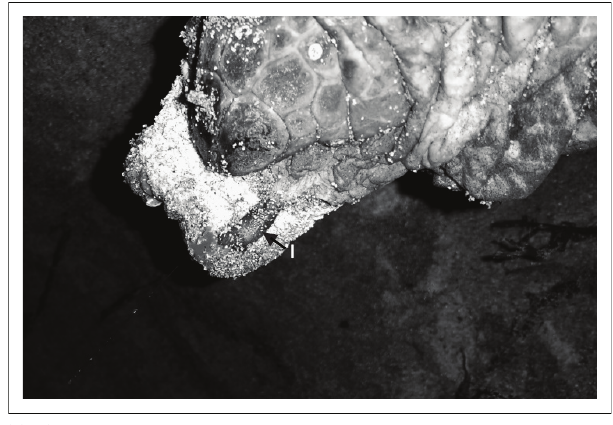
FIGURE 1: Ozobranchus margoi observed on nesting hawksbill turtle. Photo taken of tail and cloaca while eggs were being laid. FIGURE 2: Ozobranchus margoi